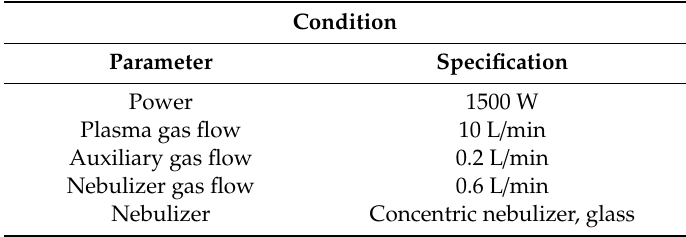
Table 1. Analytical condition used for inductively coupled plasma atomic emission spectroscopy instrument (ICP /